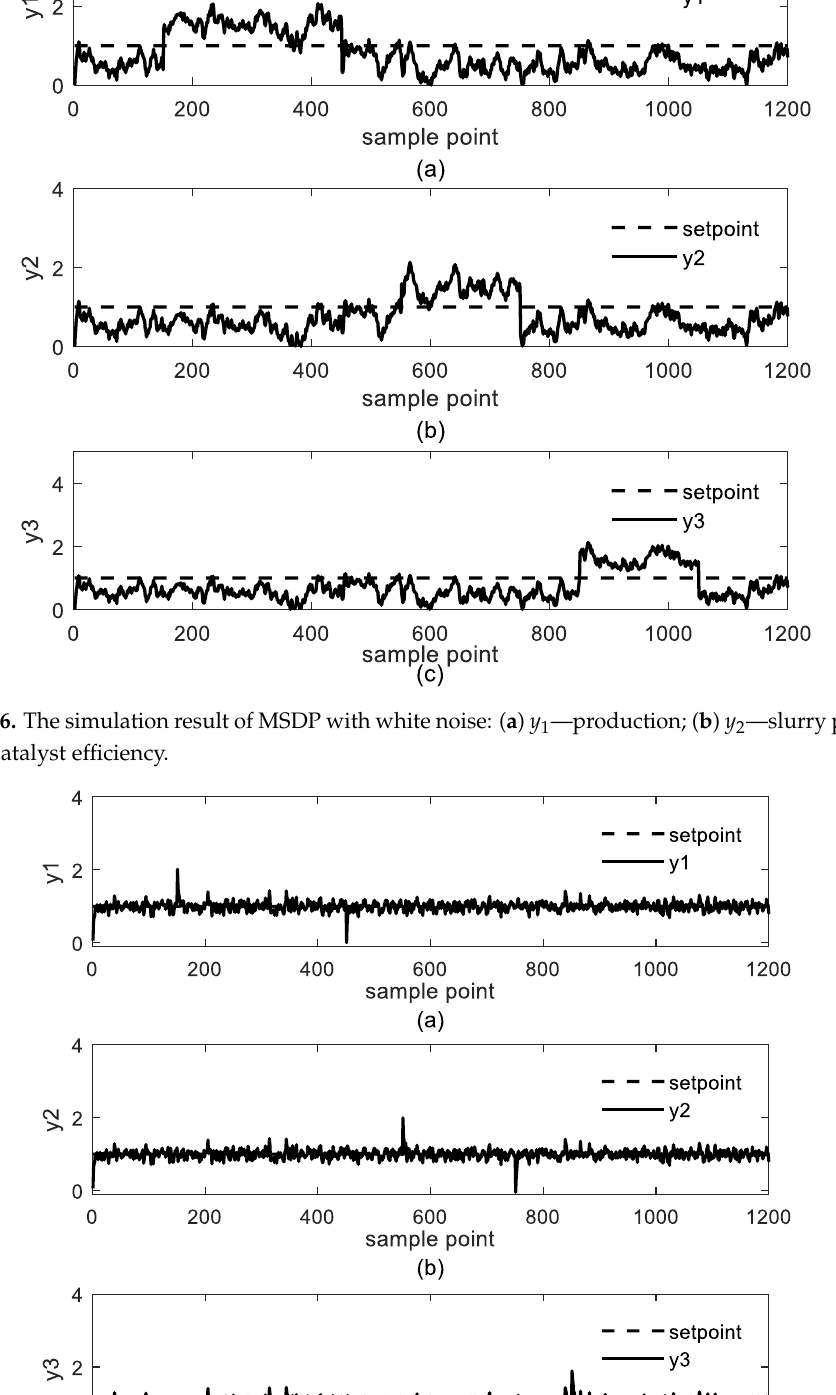
Figure 15. The simulation result of OSDP2 without noise: ( a ) y 1 —production; ( b ) y 2 —slurry polymer; ( c ) y 3 —catalyst efficiency.